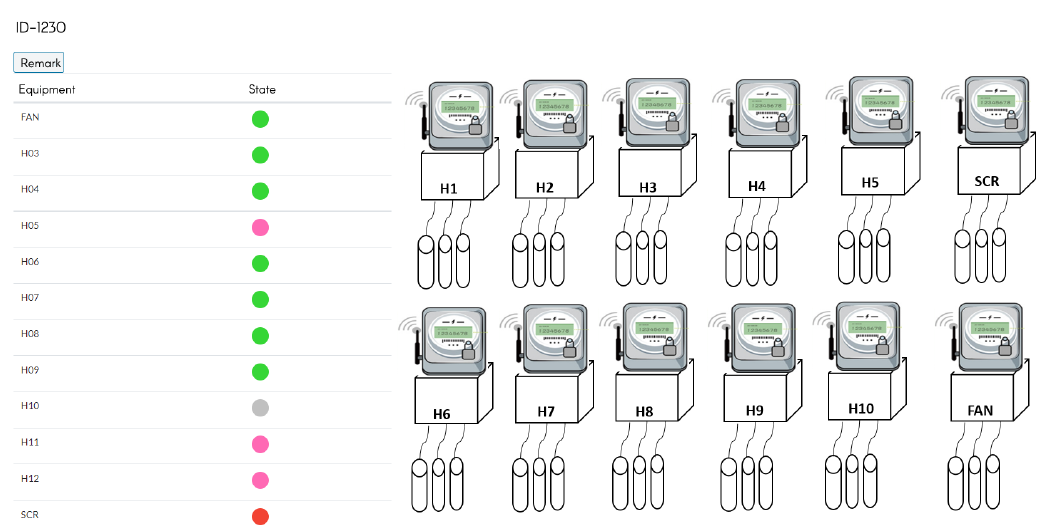
Figure 6. Hot-pressing furnace monitoring system and electricity meters.